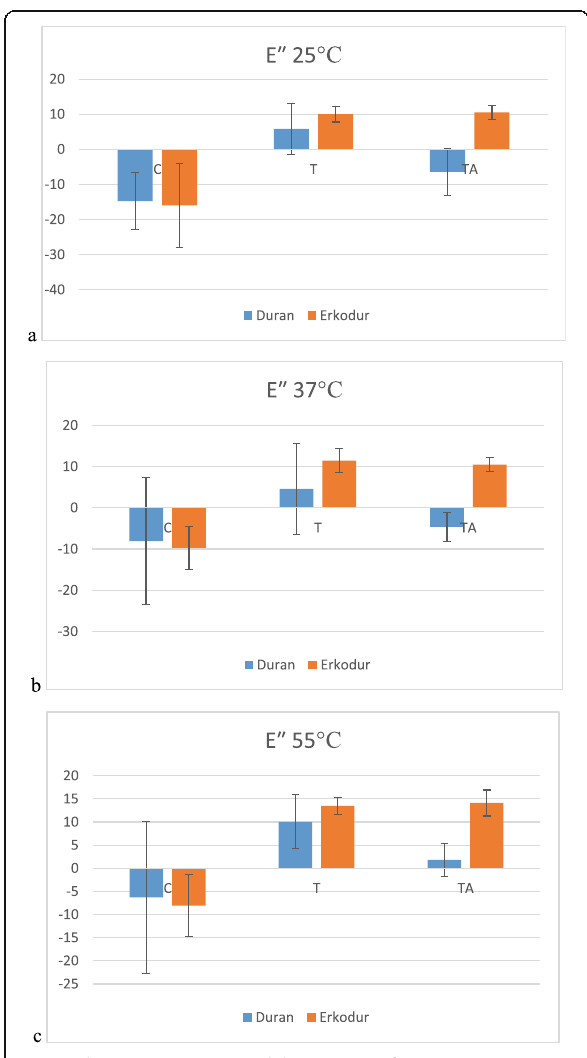
Fig. 7 Changes in viscous modulus at a 25°C, b 37°C, c 55°C